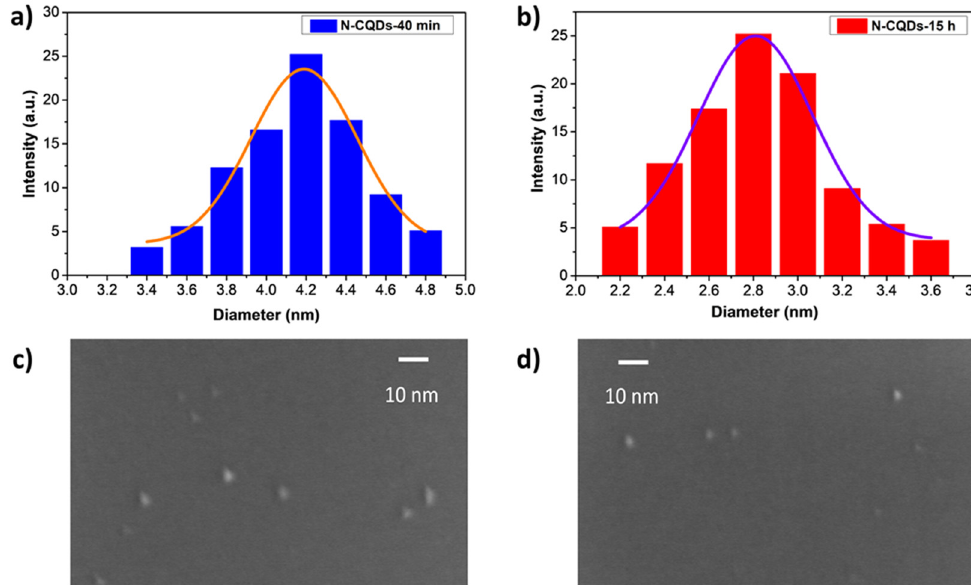
Figure 2. Particle size distribution measured using DLS: ( a ) N-CQDs-40 min and ( b ) N-CQDs-15 h; SEM images of ( c ) N-CQDs-40 min and ( d ) N-CQDs-15 h.